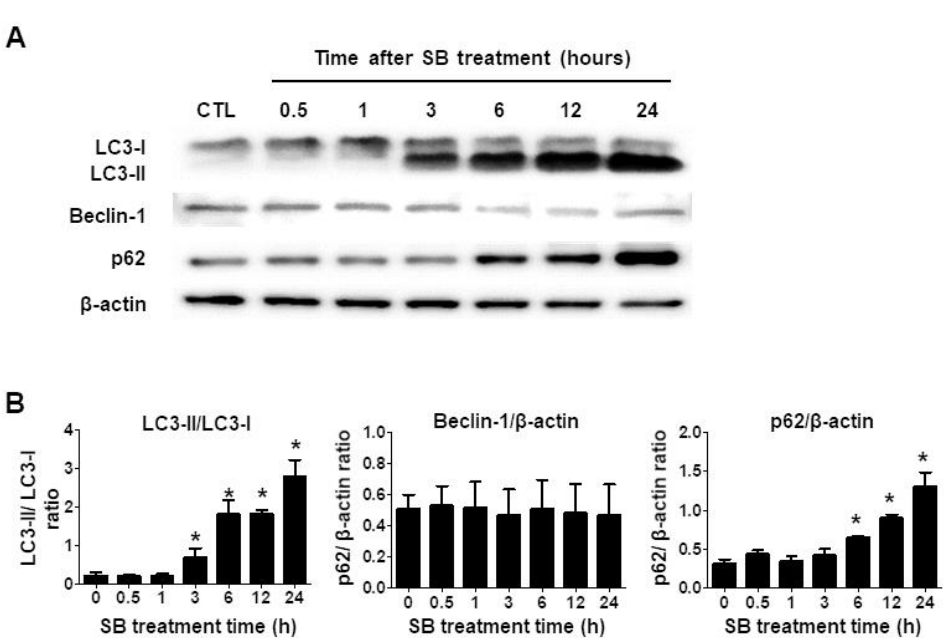
Figure 3. SB365 inhibited autophagic flux in U87-MG cells. Western blot analysis of autophagy-related proteins within 24 h of treatment with SB365. U87-MG cells in a six-well plate were treated with 10 µ M SB365 for the indicated times. ( A ) Cell lysates were subjected to western blotting for LC3-I, II, beclin-1, and p 62, and ( B ) the LC3-II / I, beclin-1 / β -actin, and p 62 / β -actin ratios were calculated. The experiment was performed independently in triplicate. * p < 0.05 vs the control.